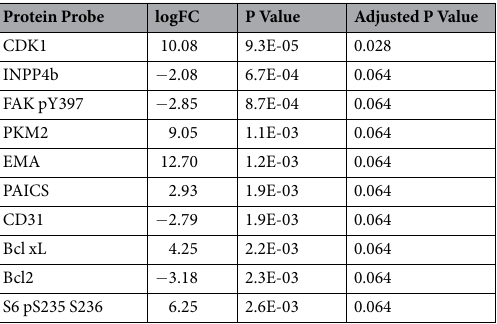
Table 3. Change in normalised biopotential vs protein log fold change between cancerous and non-cancerous samples. Correlation statistics between changes in biopotential and protein expression between cancerous and non-cancerous samples, respectively (n = 10). The tumour cellularity difference between cancerous and non- cancerous samples are also included in this model. Linear regression analysis was performed to generate these statistics, including the log2 fold change (logFC) of the trend observed, the p-statistic and adjusted p-statistic. Top 10 most significant trends are shown, with CDK1 being the only statistically significant